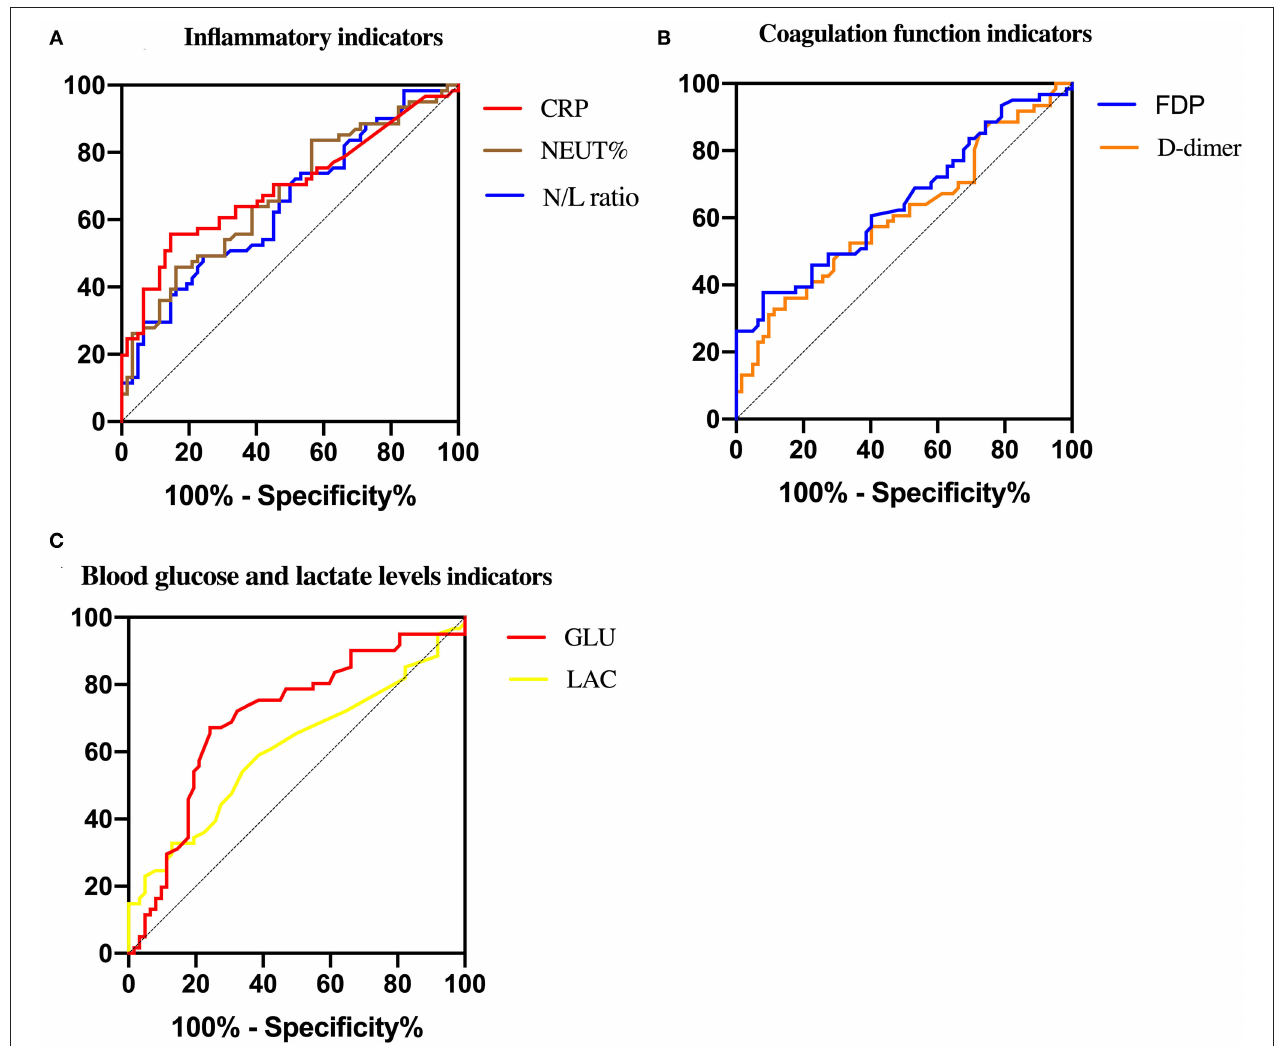
FIGURE 2 | Roc curve of predictive indicators between NEC-PVG group and NEC-non PVG group.